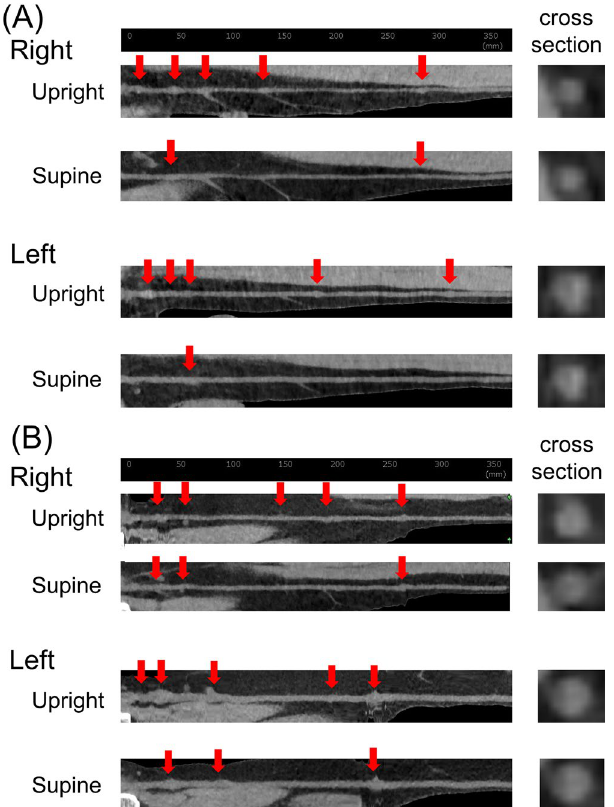
Figure 2. A representative case from the male and female volunteers. ( A ) A 39-year-old male (B.H. 181.3 cm, B.W. 72.1 kg, BMI 21.9). Upright CT detects 5/5 valves (arrows) and 18/13 tributaries (right/left sides). The cross-sectional images on the 15 cm from the SF junction showed a size of 10/22 mm 2 (right/left sides). Supine CT detects 2/1 valves (arrows) and 14/13 tributaries (right/left sides). The cross-sectional images on the 15 cm from the SF junction showed a size of 10 /15 mm 2 (right/left sides). ( B ) A 52-year-old female (B.H. 162.0 cm, CT detects 3/3 valves (arrows) and 13/14 tributaries (right/left sides). The cross-sectional images on the 15 cm from the SF junction showed a size of 16/26 mm 2 (right/left